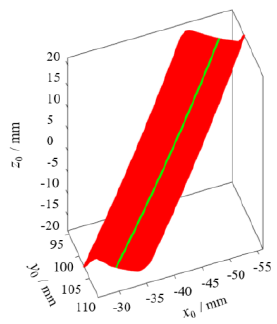
Figure 8. Point clouds extracted after multi − section scanning.